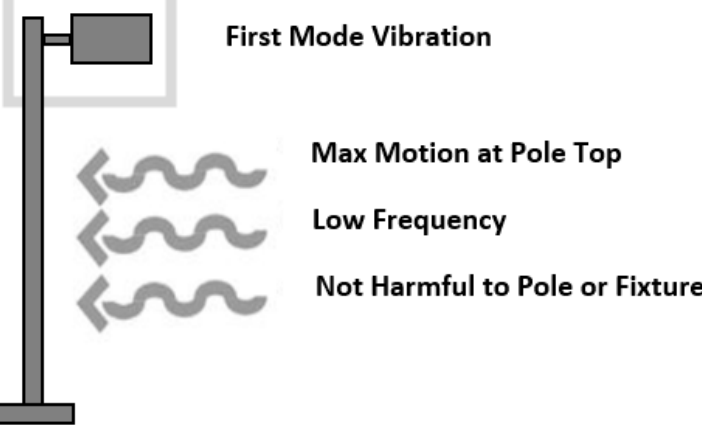
Figure 16. Sway mode of vibration, adapted from Ref. [46].